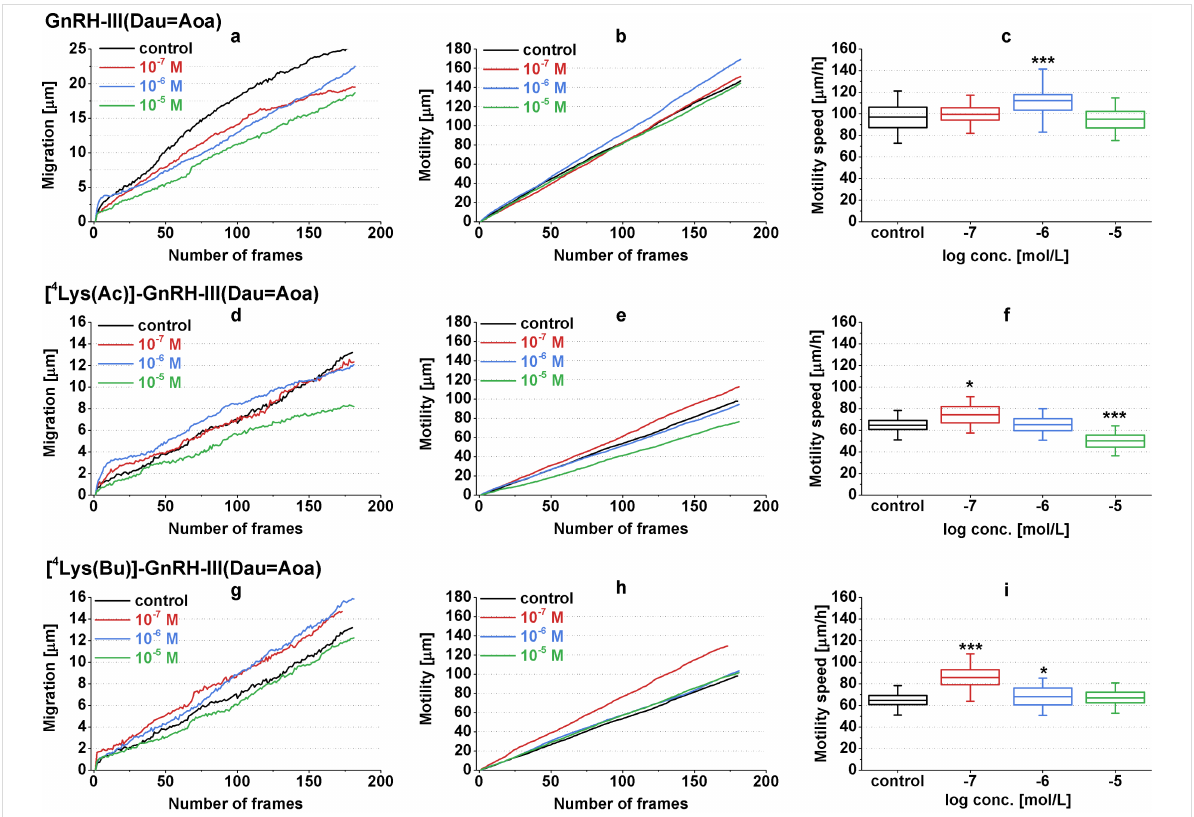
Figure 7: Effects of GnRH-III(Dau=Aoa) (a–c), [ 4 Lys(Ac)]-GnRH-III(Dau=Aoa) (d–f) and [ 4 Lys(Bu)]-GnRH-III(Dau=Aoa) (g–i) on the locomotion of A2058 cell line. The migration (a, d, g), motility (b, e, h) and motility speed (c, f, i) were investigated by HoloMonitor TM M4 holographic microscopy. Dau: daunorubicin. Data shown in the figures represent averages calculated for 50 cell/group in 180 consecutive frames. The levels of significance are shown as follows *: p < 0.05; ***: p <